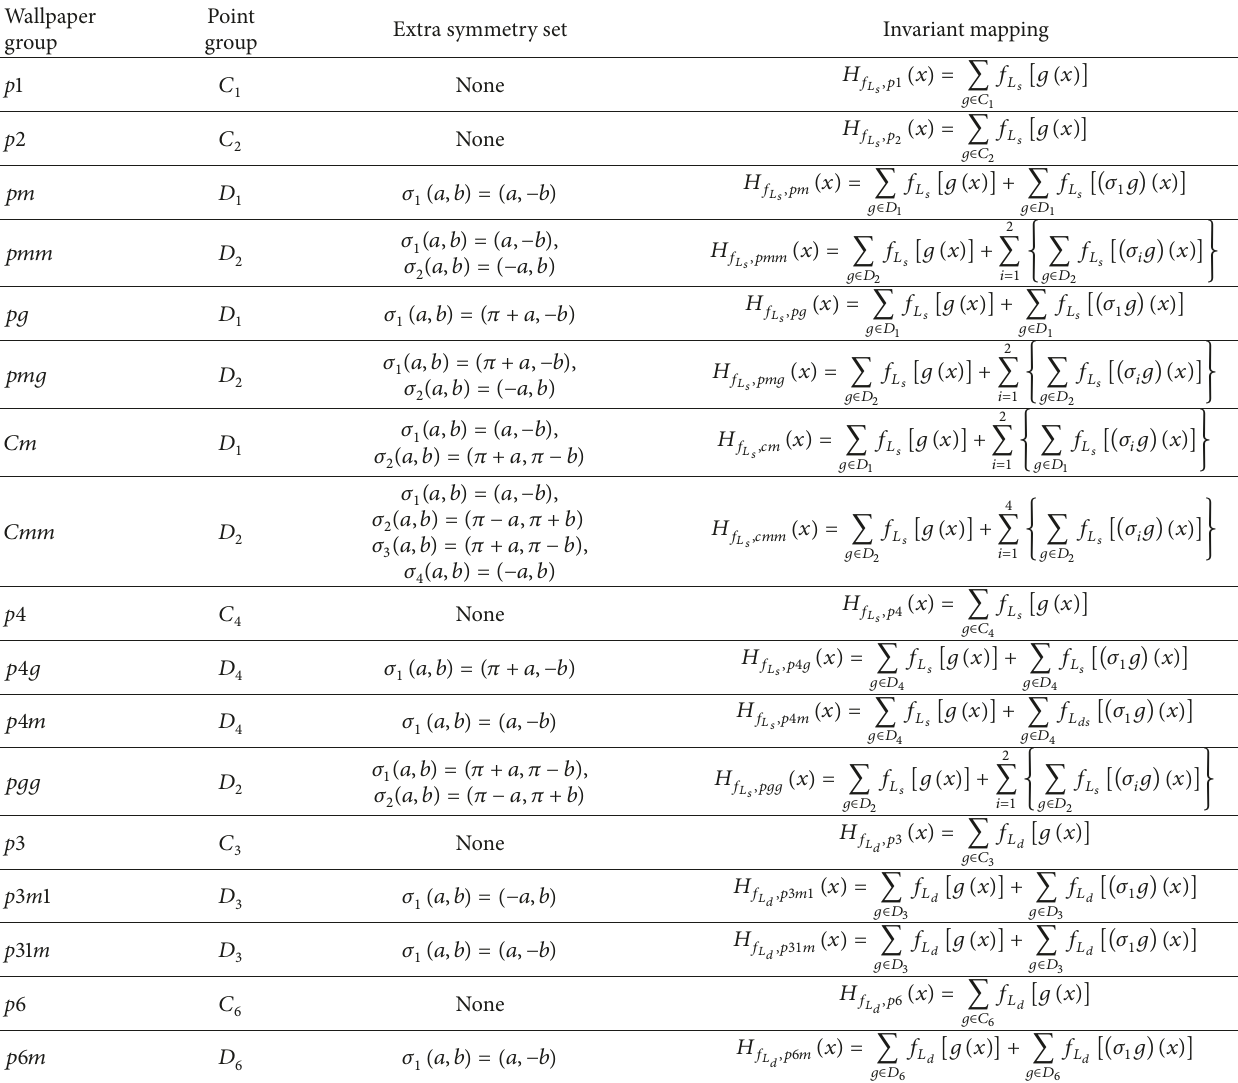
(𝑥) forms associated with 17 wallpaper groups. In the fourth column, the subscripts 𝐴 and 𝐵 𝐴 ,𝐵